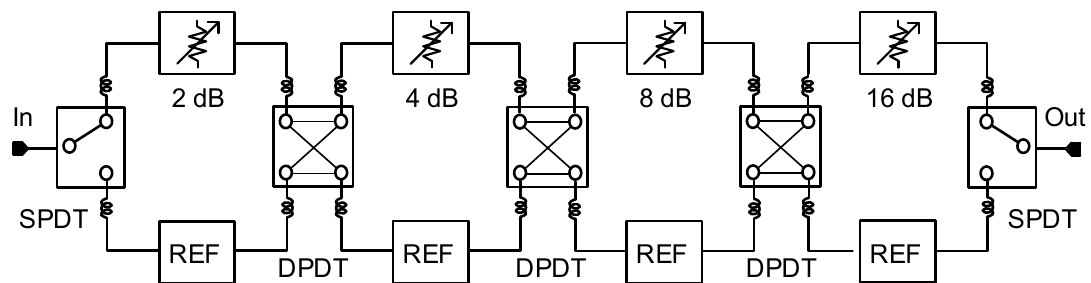
Figure 2. Schematic of the S/C/X-band GaN 4-bit digital step attenuator.